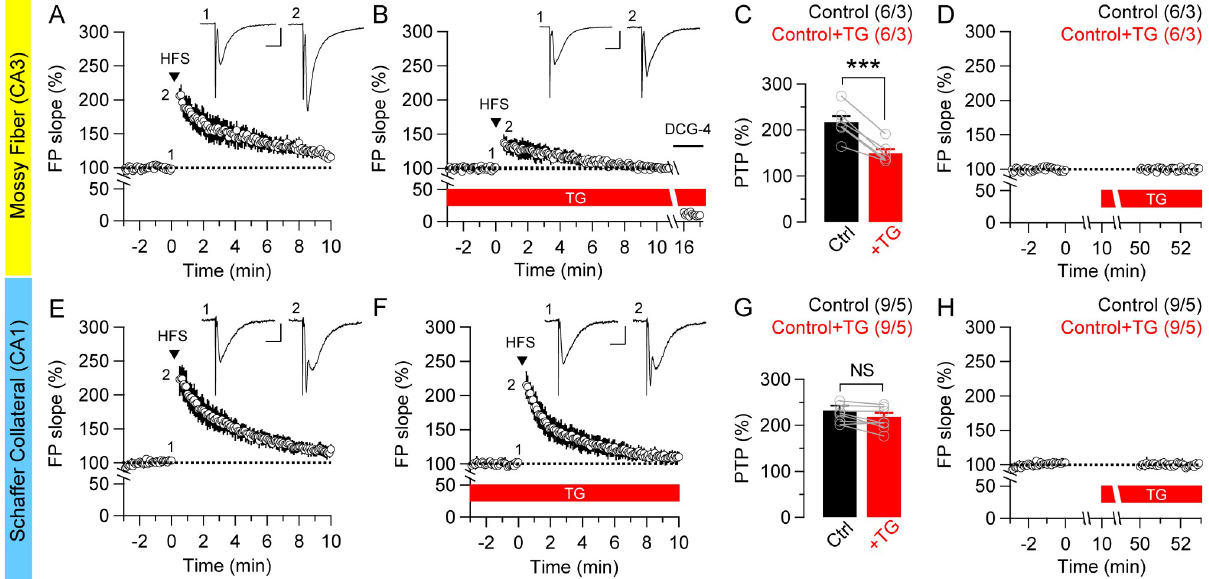
Fig 4. Depletion of ER Ca 2+ differentially affects PTP at the hippocampal MF and SC synapses. ( A & B ) After applying thapsigargin (TG: 2 μ M) for 40 min, which depletes ER Ca 2+ by irreversibly blocks SERCA activity, the magnitude of PTP by HFS is substantially decreased at MF synapses. The insets represent traces recorded before and immediately after HFS. Scale bar: 10 ms, 0.5 mV. DCG-4 (2 μ M) was applied at the end of all experiments to confirm the recording of MF synapses. ( C ) The summary bar graph for the mean magnitude of PTP induction in the absence or presence of TG at MF synapses (Control: 216.7 ± 13.4%; +TG: 149.8 ± 8.4%; p = 0.00045, paired t -test). ( D ) Effects of TG treatment on basal transmission. Treatment of TG for 40 min has no effect on the fEPSP slope at MF synapses. ( E & F ) Similarly, mean value of time-dependent changes in the fEPSP slope was recorded in the absence (E) or presence (F) of TG at hippocampal SC synapses. Note that TG treatment has no effect on PTP induction. ( G ) The summary bar graph for the mean magnitude of PTP induction in the presence of TG at SC synapses (Control: 232.5 ± 9.9%; +TG: 218.7 ± 8.8%; p = 0.34, paired t - test). ( H ) Effects of TG treatment on basal transmission. Treatment of TG for 40 min has no effect on the fEPSP slope at SC synapses. All data are mean ± SEM ( ��� p < 0.001, NS: not significant; Student’s t -test). The value in parentheses indicates the number of hippocampal slices (left) and the number of mice (right) used in each